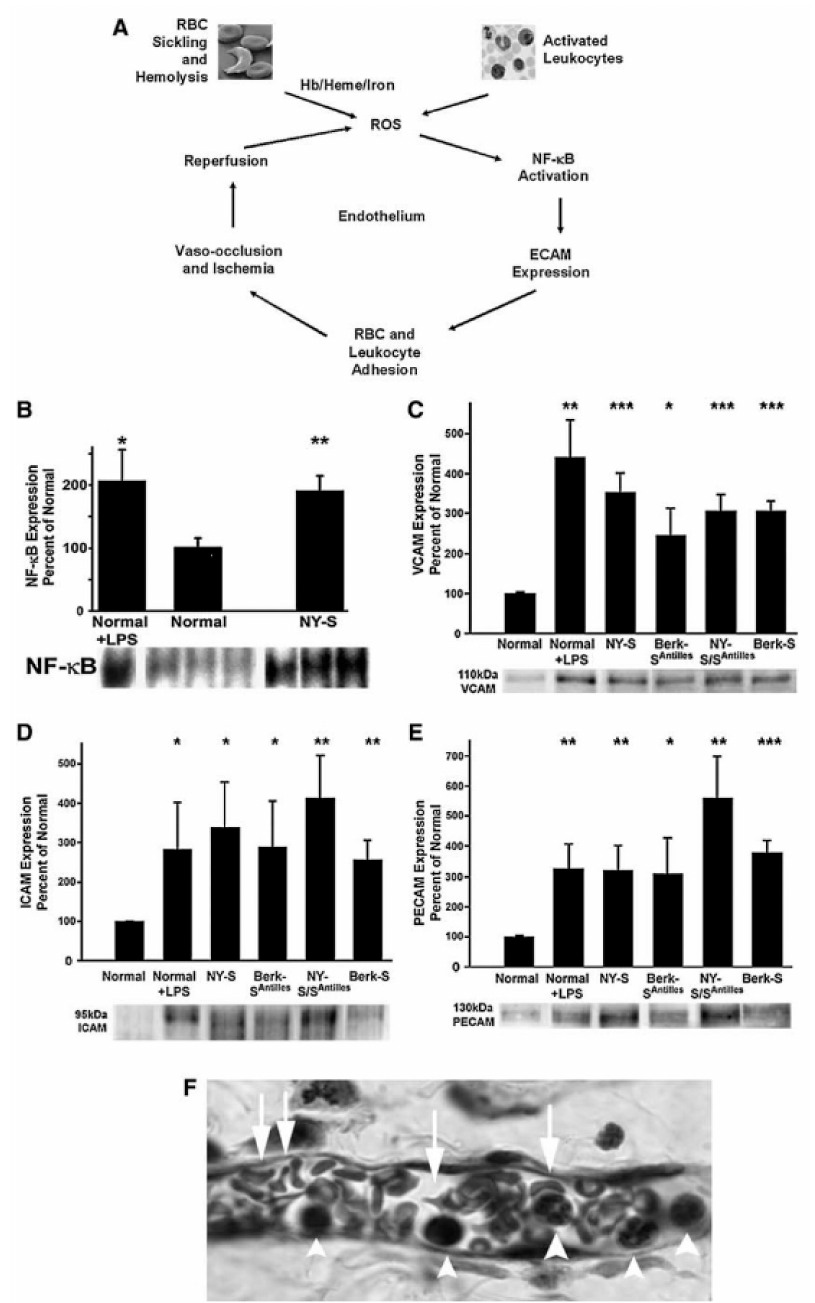
Figure 2. Hemolysis, oxidative stress, inflammation and adhesion lead to vasoocclusion and ischemia / reperfusion injury in sickle cell disease. ( A ) A vicious cycle of oxidative stress, inflammation and vasoocclusion in sickle cell disease is initiated by hemolysis of sickle RBCs, releasing hemoglobin and heme into plasma, iron from which catalyzes additional ROS production. Free heme further reacts with activated leukocytes to amplify the expression of ROS and proinflammatory cytokines, which promote endothelium-derived ROS, activating endothelial NF-kB-dependent pathways and endothelial cell adhesion molecule (ECAM), vascular cell adhesion molecule-1 (VCAM-1), intracellular cell adhesion molecule-1 (ICAM-1), P-selectin and others, promoting vasoocclusion and subsequent tissue ischemia. Thus, these vessels can subsequently reopen, and reperfusion leads to the conversion of xanthine dehydrogenase to xanthine oxidase, promoting extra ROS production. ( B ) Electrophoretic mobility shift assay (EMSA) demonstrates that LPS injection induces NF-kB in the lungs of